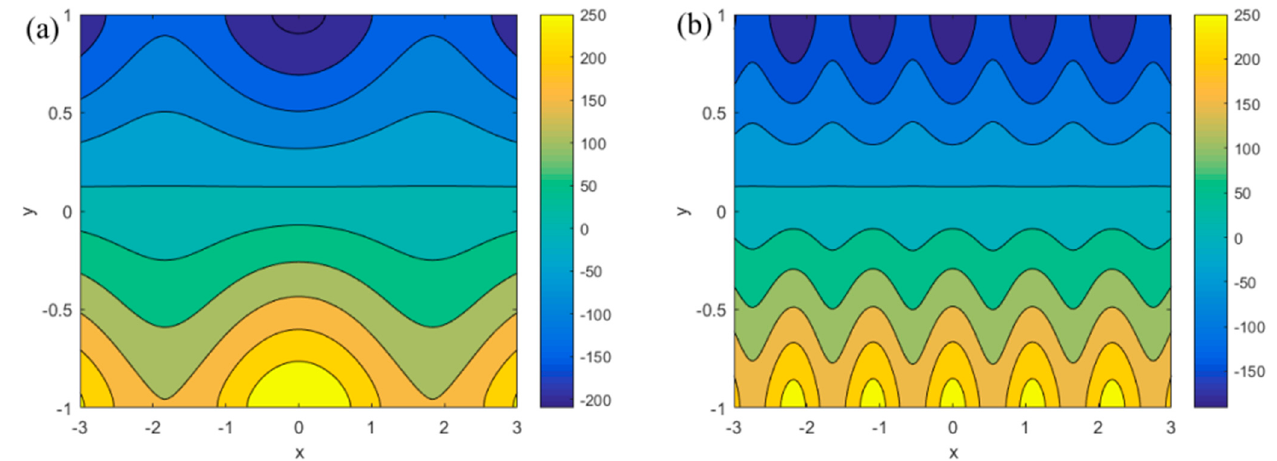
Figure 3. Changes in streamlines for different m and n ( Ha = 1, κ = 8, δ = 0, u r = 0.6, R = 0.6, α = 3, β = 3, ξ 1 = 0.15, ξ 2 = 0.18). ( a ) m = 1.5, n = 1.8; ( b ) m = 5.5, n = 5.8.